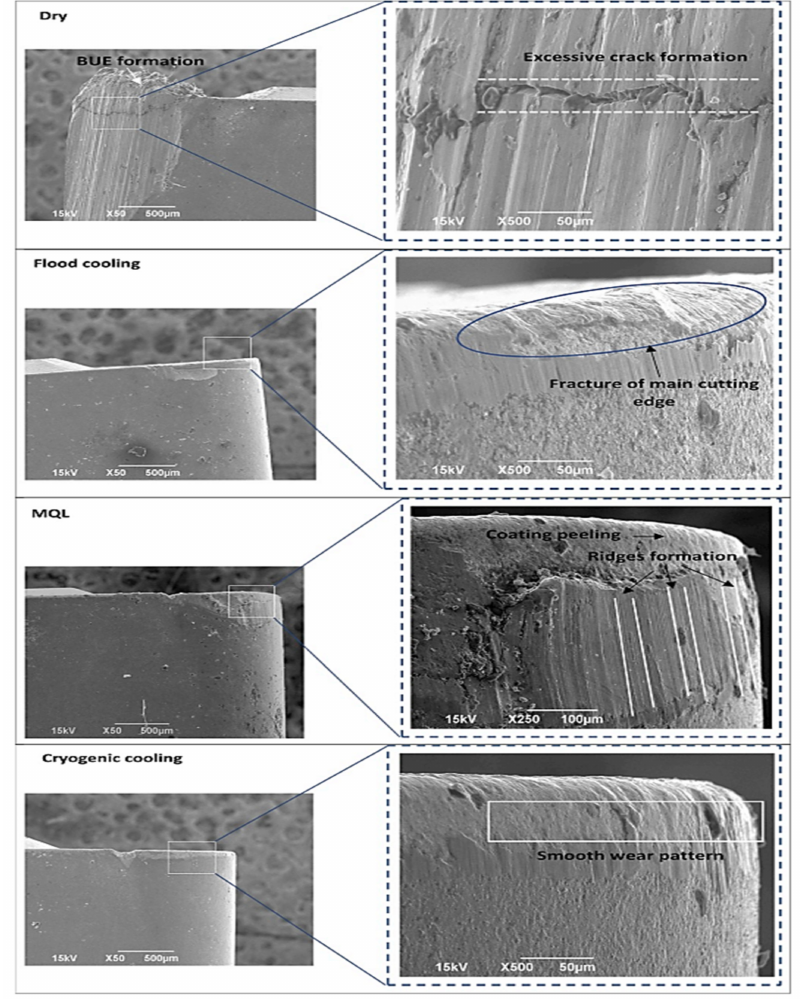
Figure 22. Micrographs of the flank face of cutting inserts under different cutting environments, reprinted with permission from ref. [89]. Copyright 2020 Elsevier